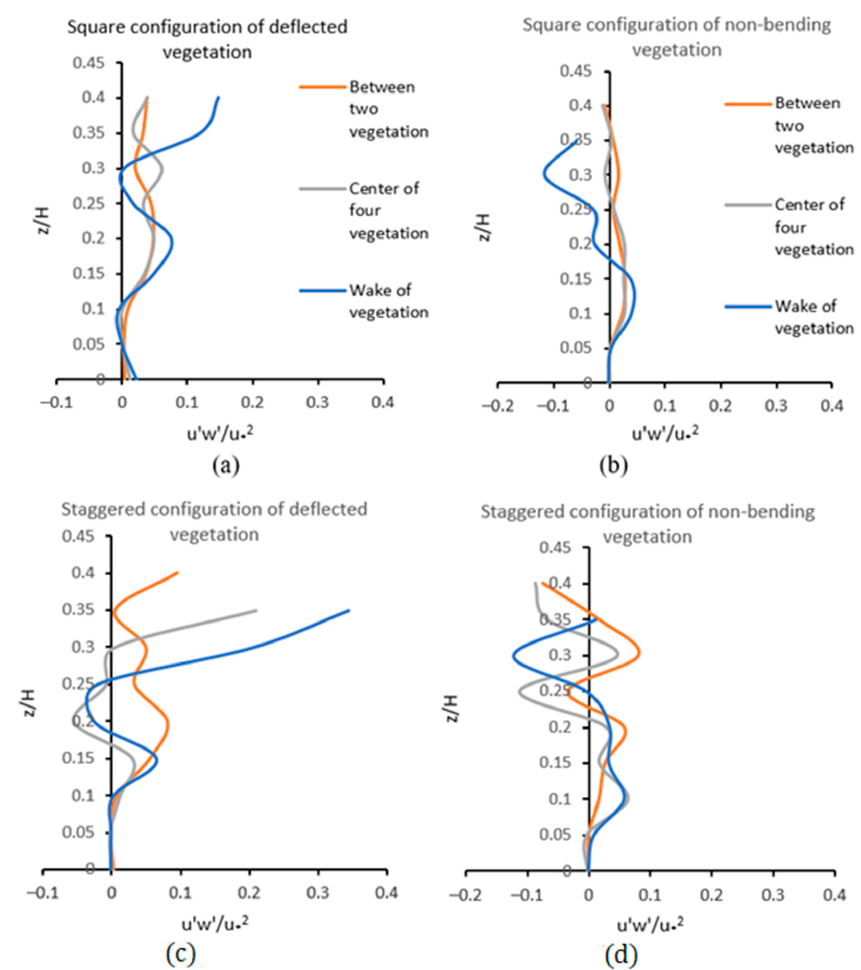
Figure 15. Normalized Reynolds Shear Stress in (water depth = 20 cm): ( a ) Square configuration of deflected vegetation in the wake of vegetation, between two vegetation elements and in the center of four vegetation elements with λ = 0.04; ( b ) Square configuration of non-bending vegetation in the wake of vegetation, between two vegetation elements and in the center of four vegetation elements with λ = 0.05; ( c ) Staggered configuration of deflected vegetation in wake of three random vegetation elements with λ = 0.07; ( d ) Staggered configuration of non-bending vegetation in wake of three random vegetation elements with λ =